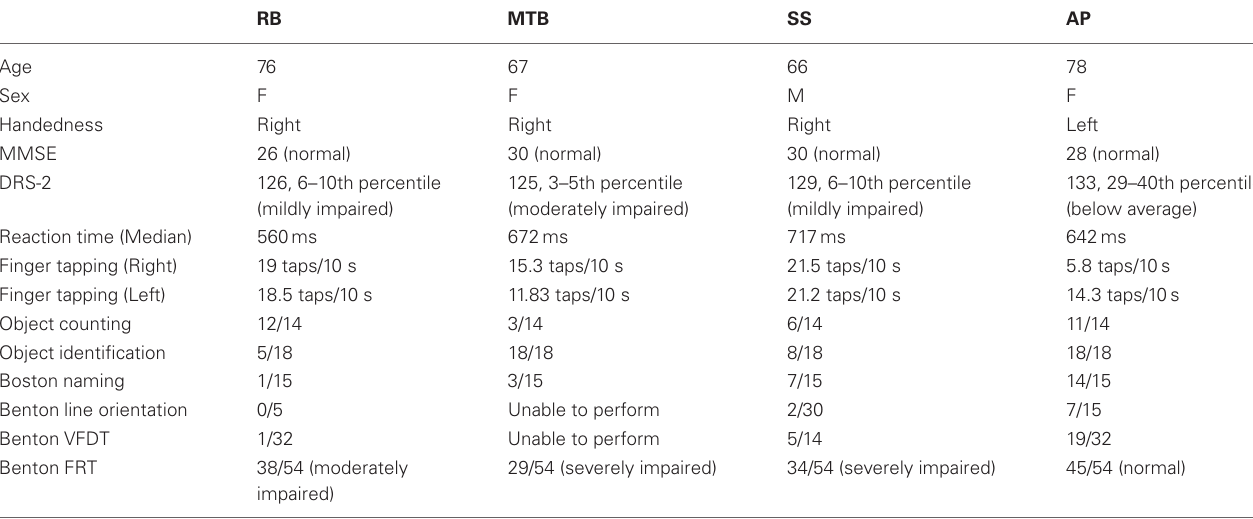
Table 1 | Demographic information and behavioral scores of four patients with